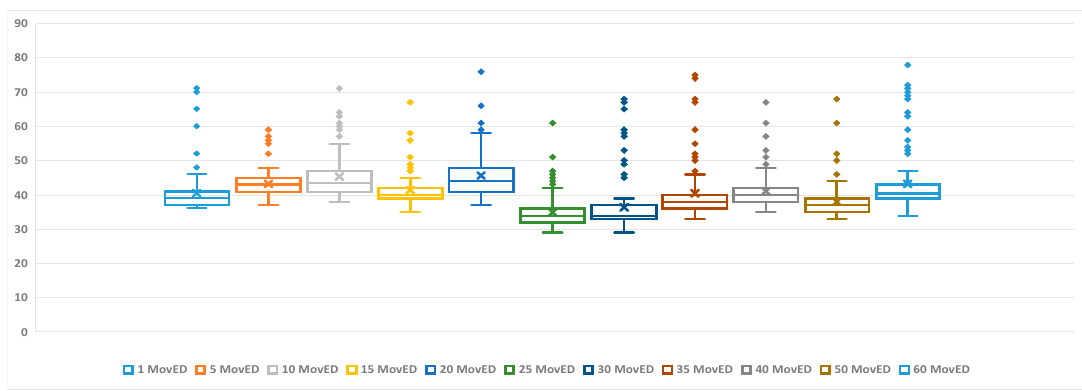
Figure 16. Activity Controller average response time.